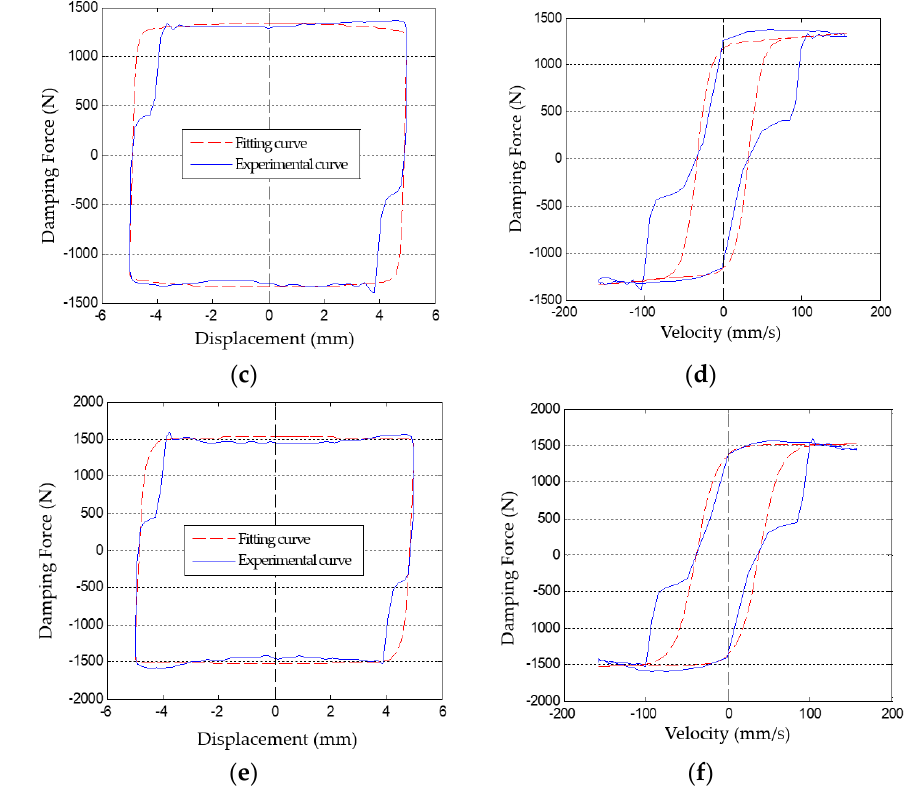
Figure 5. Dynamic characteristics of MR damper under control current of 0, 2, 4 A: ( a ) Force-displacement curve (0 A); ( b ) Force-velocity curve (0 A); ( c ) Force-displacement curve (2 A); ( d ) Force-velocity curve (2 A); ( e ) Force-displacement curve (4 A); ( f ) Force-velocity curve (4 A).